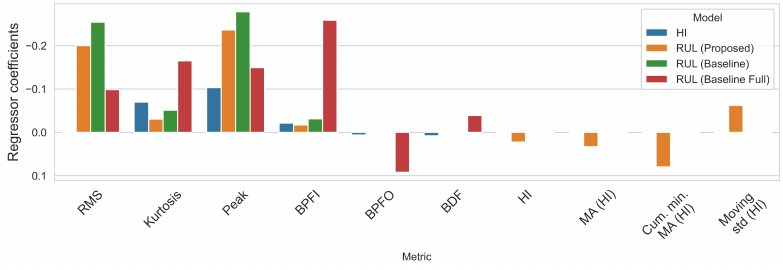
Figure 21. Regressor coefficients for each model on the SMLL